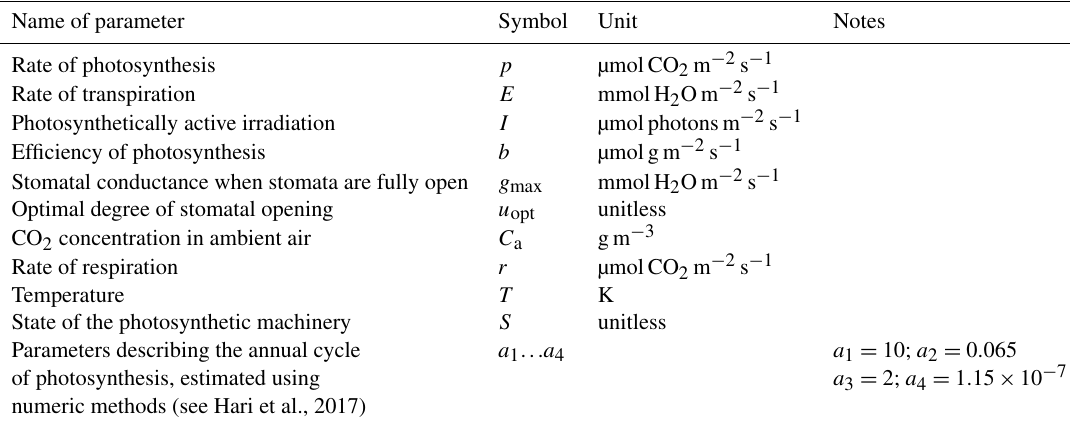
Table 1. Symbols and parameters in model